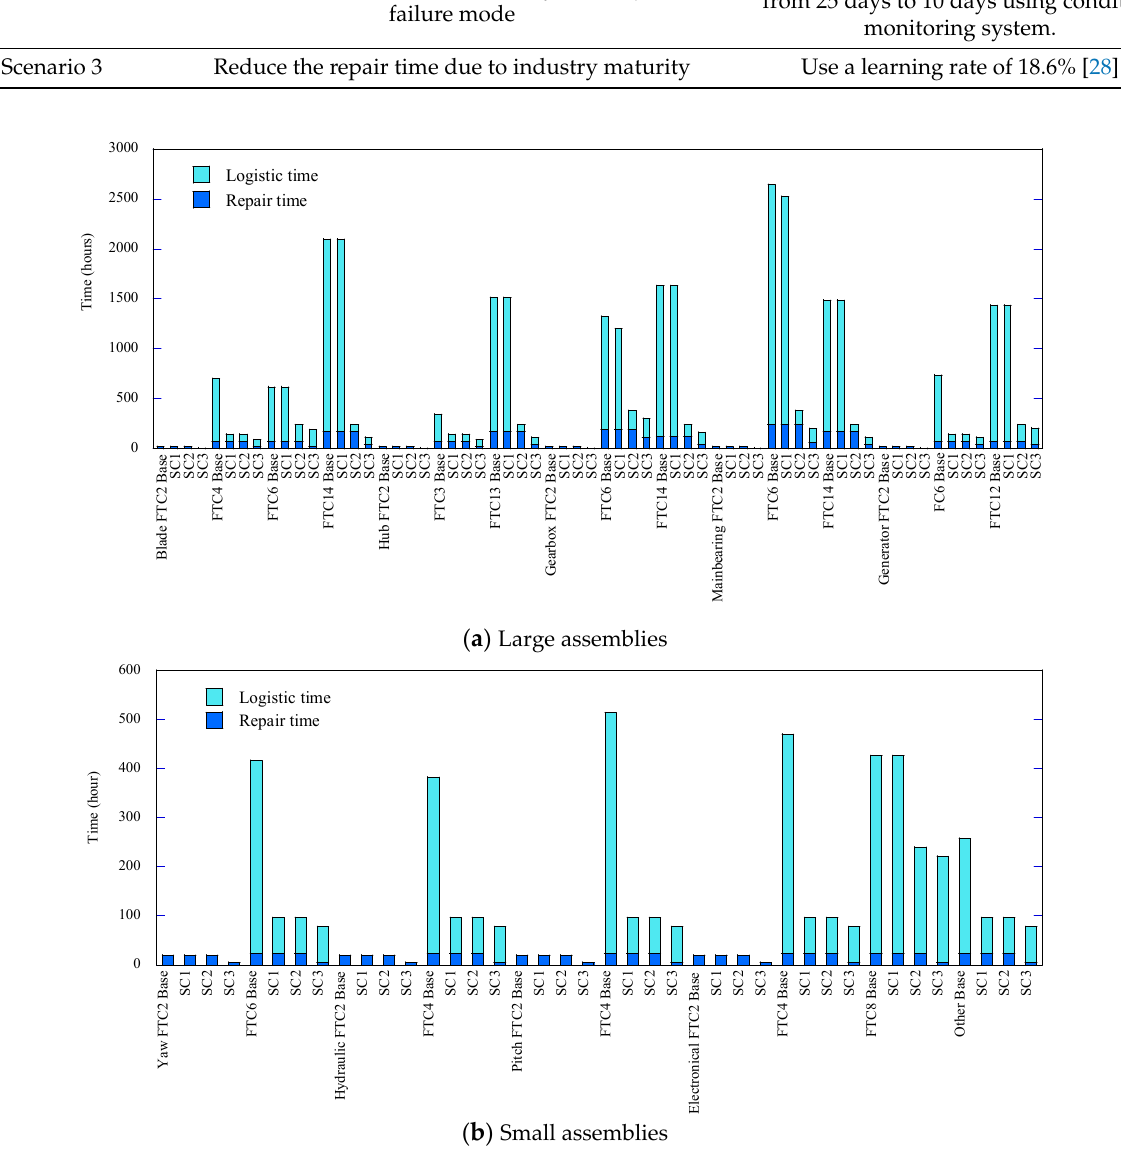
Figure 5. Downtime of each FTC for the baseline case and three scenarios.